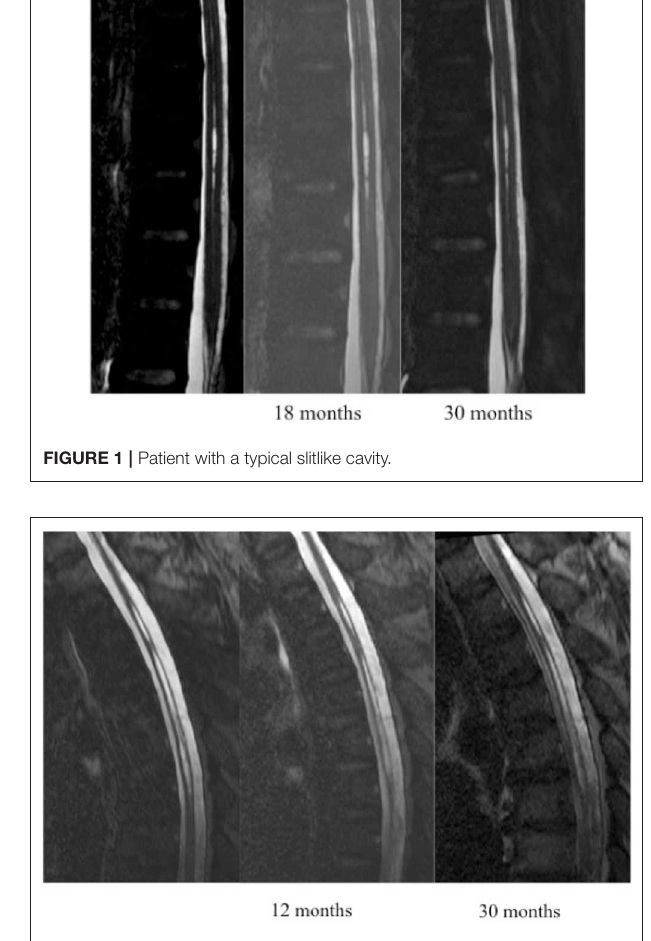
FIGURE 2 | Patient with an atypical slitlike